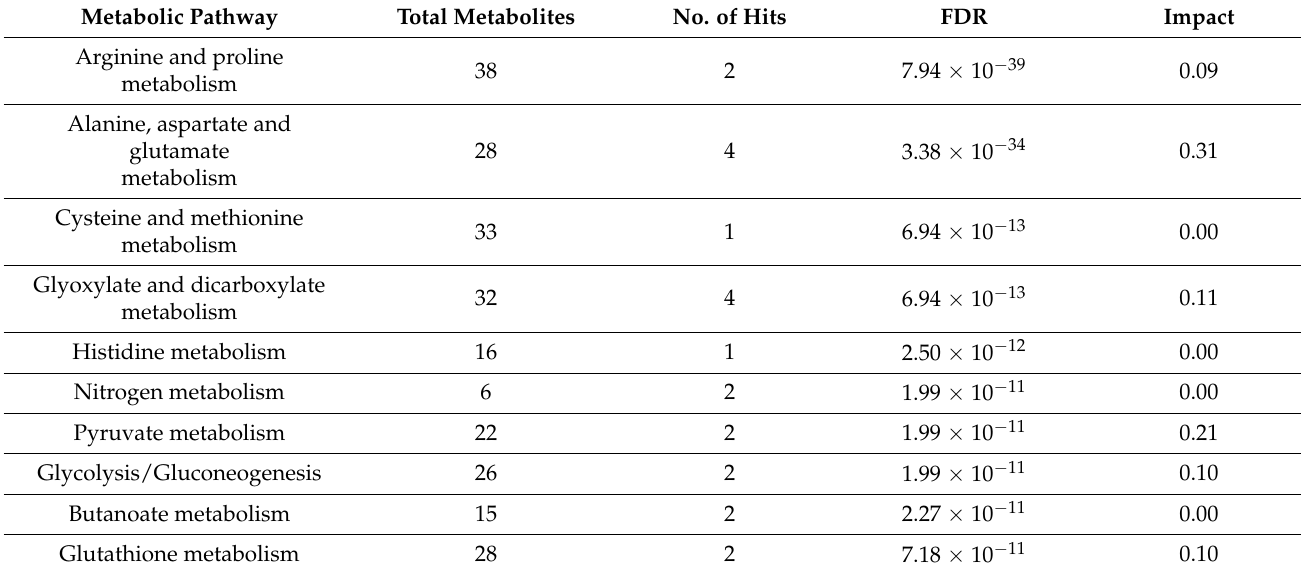
Table 2. Pathway topological analysis showing the human metabolic pathways most significantly affected by acute sore throat disease pathology; the number of metabolites featured in each pathway, and the number of metabolite ‘hits’ are shown, as are the corresponding FDR-corrected p values for these contributions. The Homo sapiens pathway library was selected, which contained a total of 80 pathways. The chosen pathway library code was hsa (KEGG organisms abbreviation). The selected pathway enrichment analysis method and node importance measure for this toplogical analysis were globaltest and relative betweenness centrality, respectively. The ‘betweenness centrality’ determines the shortest path number passing through the node, and this is also employed as an importance measure for metabolites, since in this case the metabolic network is directed. The impact is the pathway impact value, which represents the matched metabolite node cumulative percentage values from all such nodes featured (computed from this pathway topological analysis). As many as 13 other metabolic pathways had FDR-corrected p values lying between 7.18 × 10 − 11 and 0.045, and these also may be implicated in the pathogenesis of pharyngitis, although less significantly so than those displayed in this